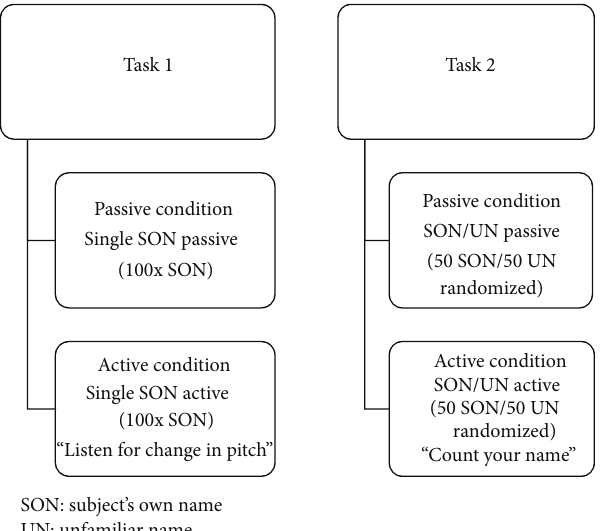
Figure 1: Experimental ERP